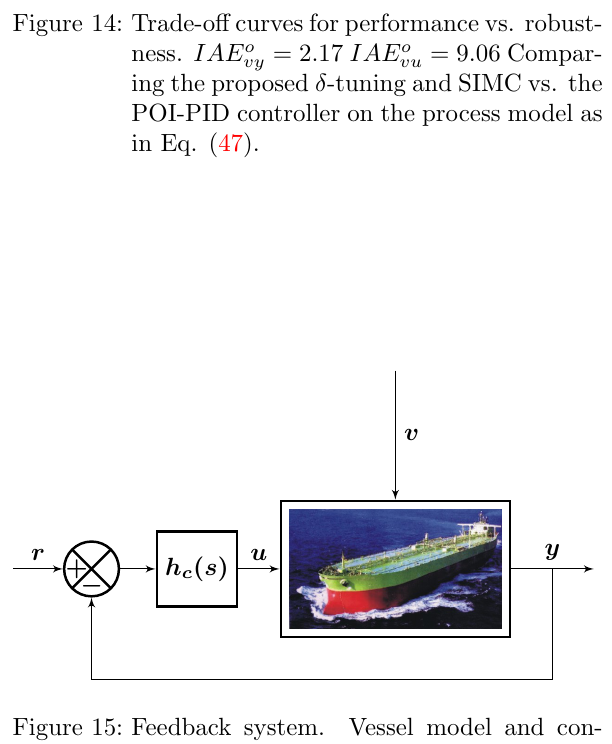
Figure 15: Feedback system. Vessel model and con- troller h c ( s ). The input u is the com- manded rudder angle and the output y is the perturbed yaw angle about zero. v is